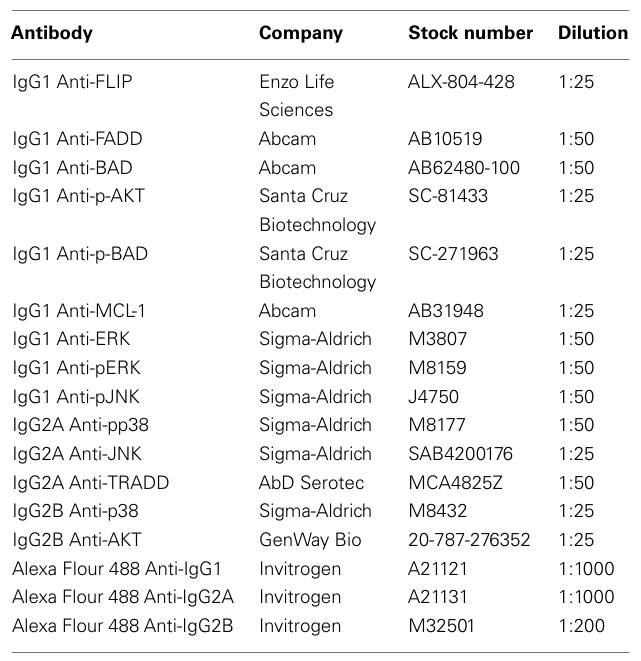
Table 1 |Antibodies used in flow cytometry.